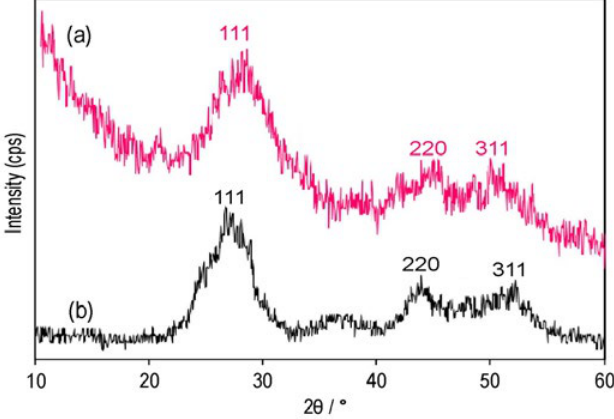
Fig. 2. XRD patterns of (a) L- and (b) D-cyst-CdS-QDs .